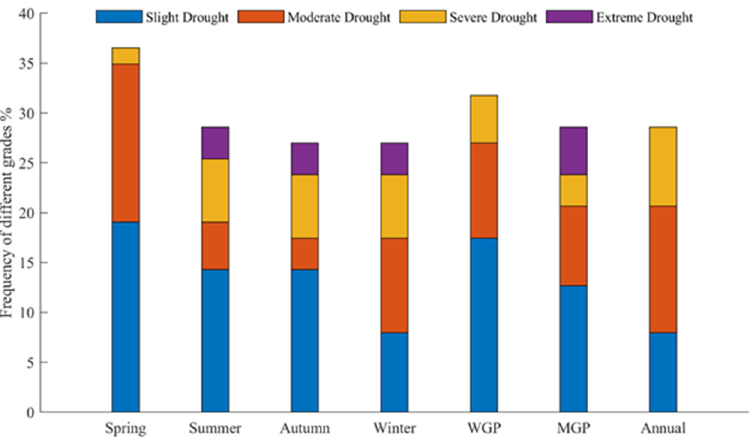
Figure 3. Frequency of drought occurrence in different timescales.